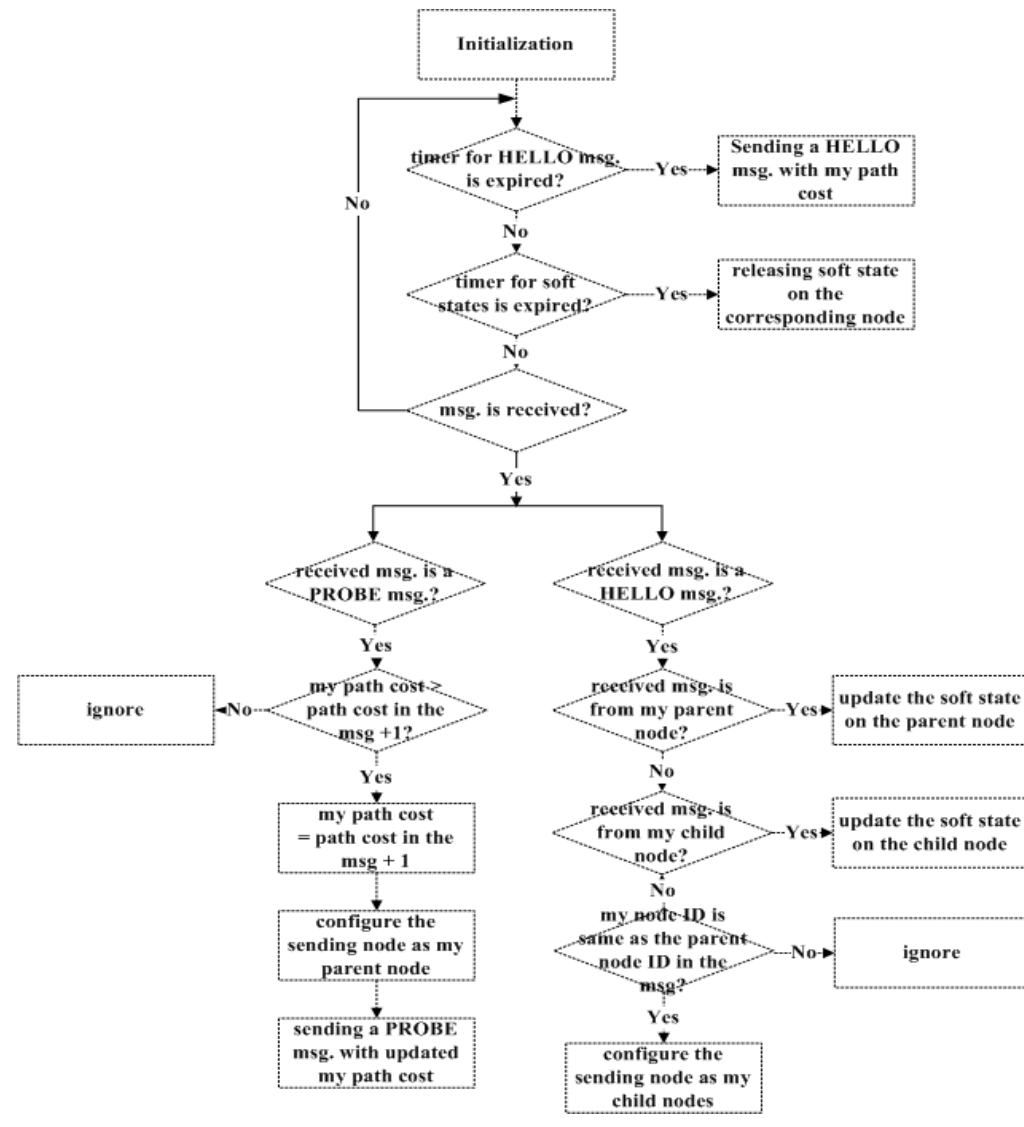
Figure 5. Tree construction